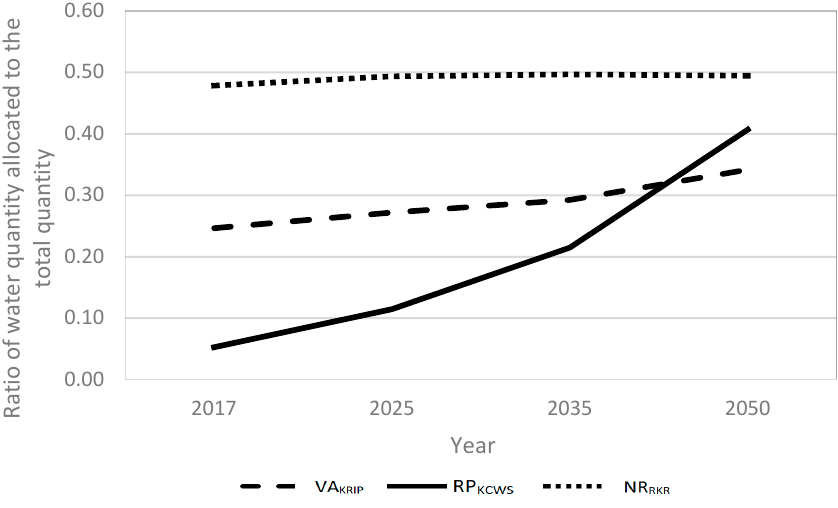
Figure 14. Ratio of water allocated to users to the total quantity.